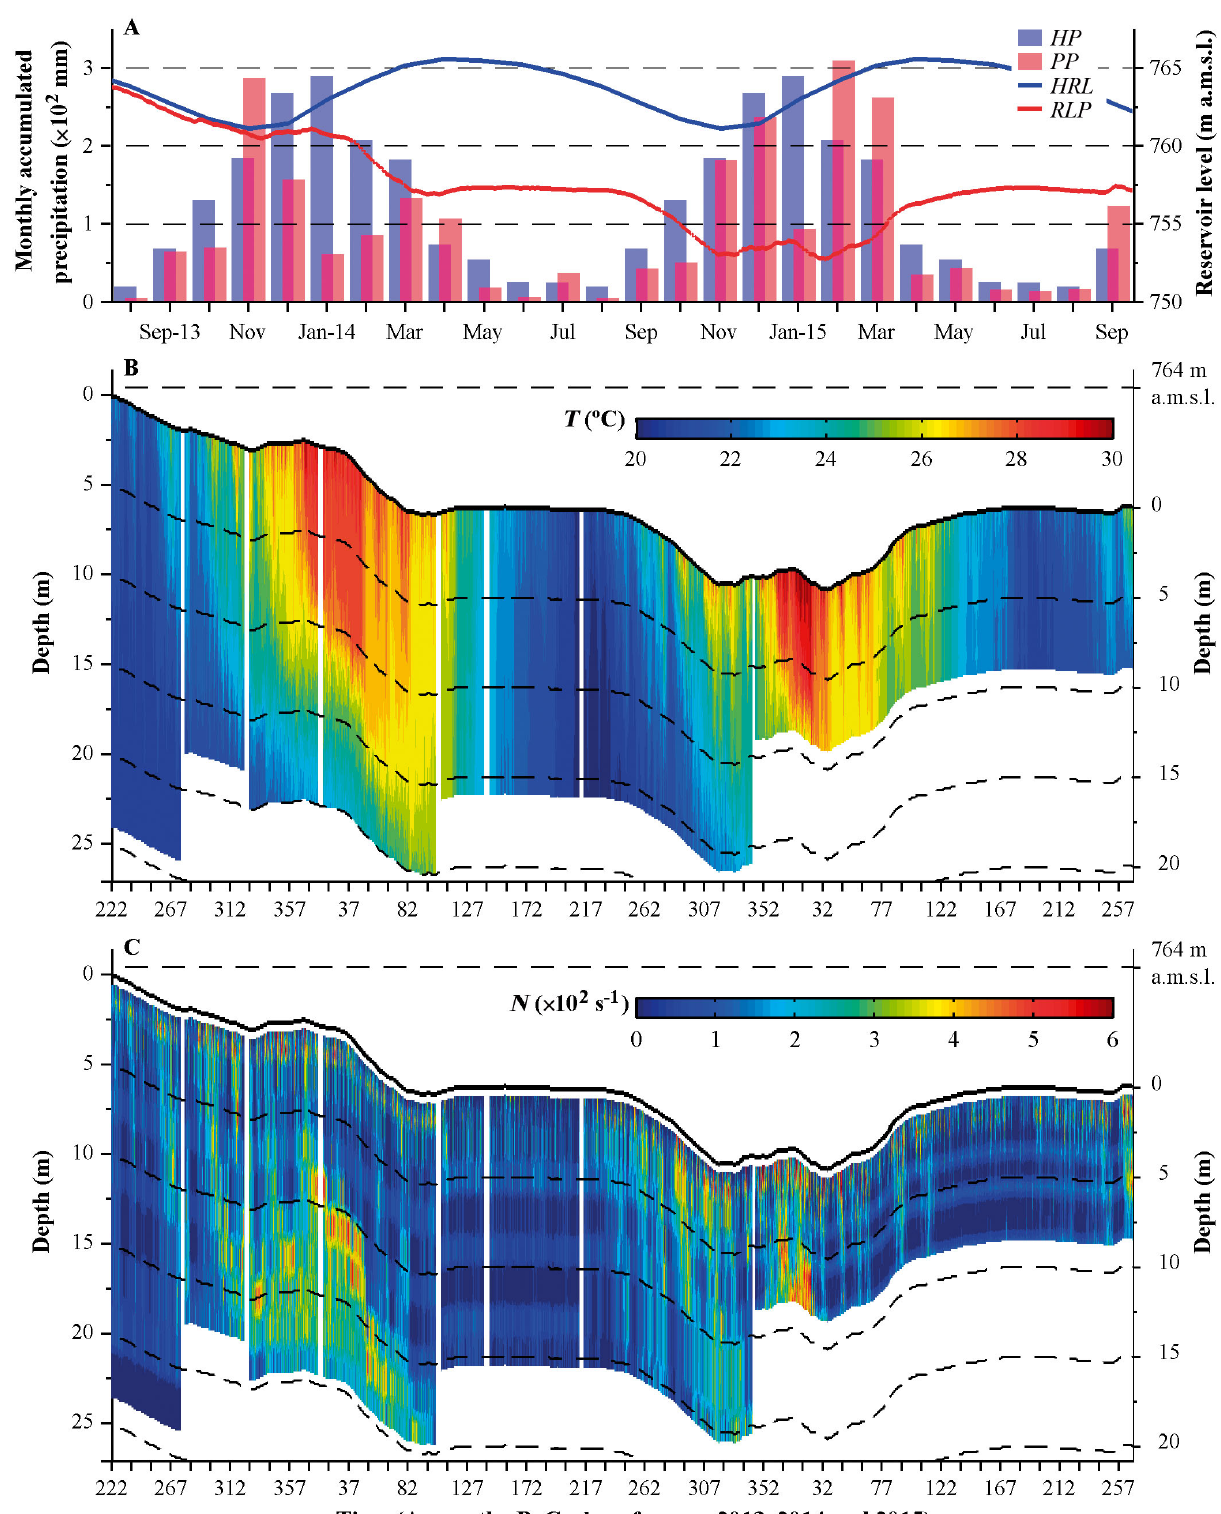
Fig. 3. Time series of (A) monthly mean accumulated precipitation ( HP : averaged historical precipitation for 1961−2015, PP : precipitation in the analyzed period) and daily water level ( HRL : averaged historical reservoir level for 1963−2015, RLP : reservoir level in the analyzed period); (B) water column temperature ( T) ; and (C) buoyancy frequency ( N ). a.m.s.l.: above mean sea